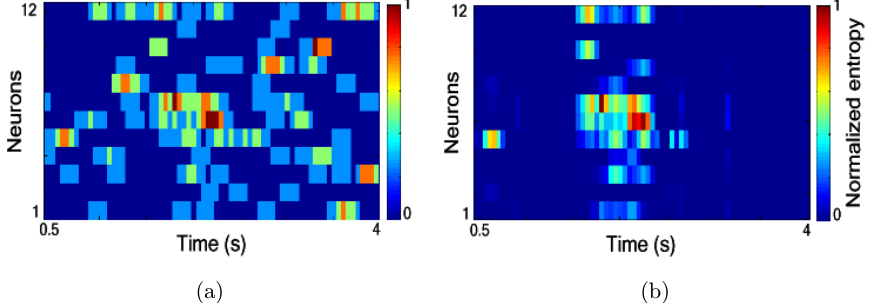
Fig. 6. Neuronal ensemble entropy coding and sparse coding during the working memory task. (a) Entropy coding. (b) Sparse